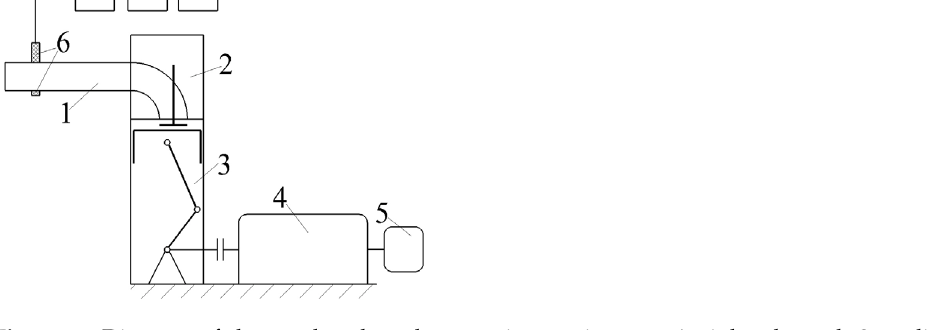
Figure 1. Diagram of the test bench and measuring equipment: 1—inlet channel; 2—cylinder head; 3—cylinder-piston group of the engine; 4—electric engine; 5—frequency converter; 6—hot-wire anemometer sensors (channels w x and α x ); 7—hot-wire anemometer; 8—analogue-to-digital converter;